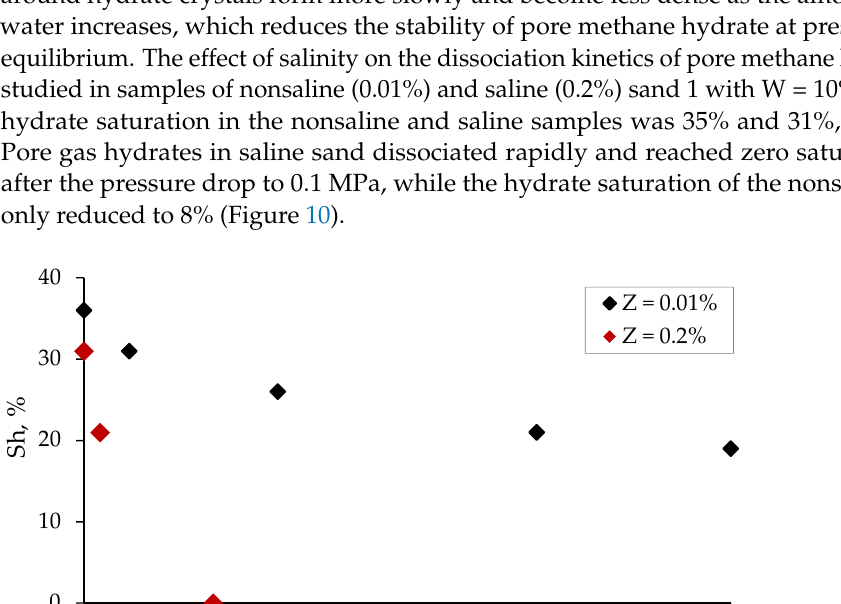
Figure 11. Time-dependent hydrate saturation in the frozen sand 2 sample (W = 18%) after the pressure dropped to 0.1 MPa at −3.5 °С and −6.5 °С. However, pore gas hydrates dissociate especially rapidly at temperatures beyond the self-preservation range (50 °С). The hydrate saturation of frozen sand 1 containing 7% of montmorillonite clay (W = 17%) was two times lower at −50 °С than it was at −7 °С twenty- two h after the pressure dropped (Figure 12), and the difference became four-fold by the end of the run (50 h). After 72 h, pore methane hydrate was undetectable in the samples cooled to −50 °С, but hydrate saturation remained stable (at ~12%) in the case of −7 °С.